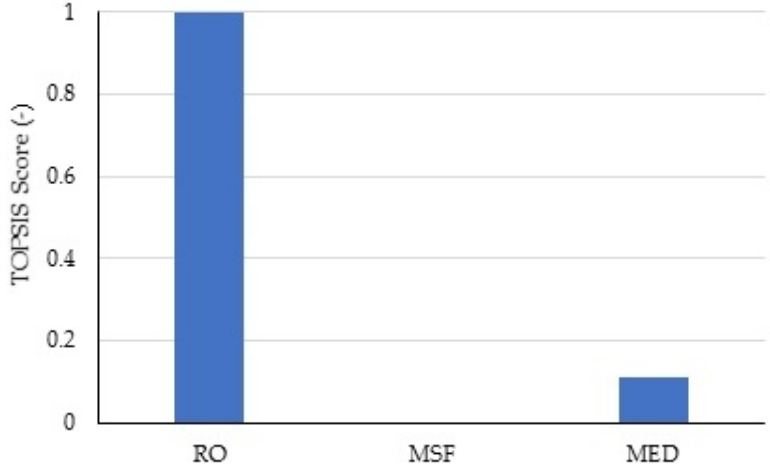
Figure 16. Final results of the MCDA. TOPSIS score: the higher, the better.